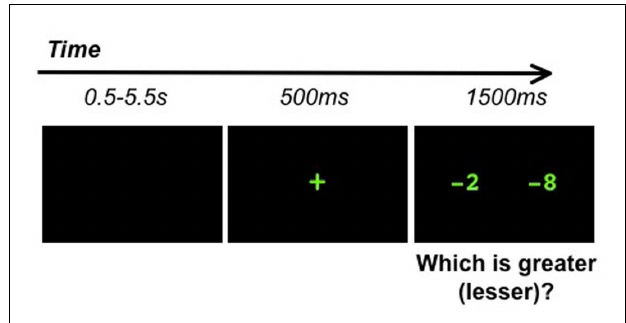
FIGURE 1 |Task timing. Each trial began with a variable fixation period (0.5–5.5s), followed by a fixation cross (500ms) and presentation of two numbers for magnitude comparison